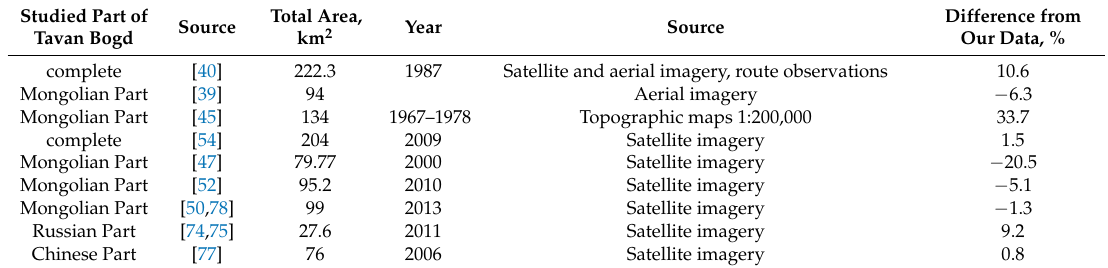
Table 8. Estimation of glacierized area of Tavan Bogd by different authors.